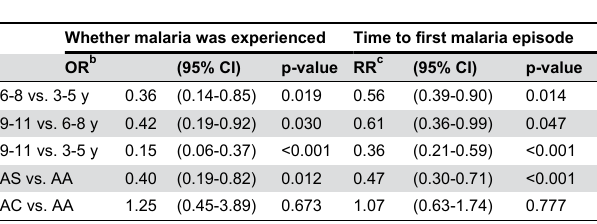
Table 2. Multivariate regression analysis: effects of age and Hb type on malaria risk.